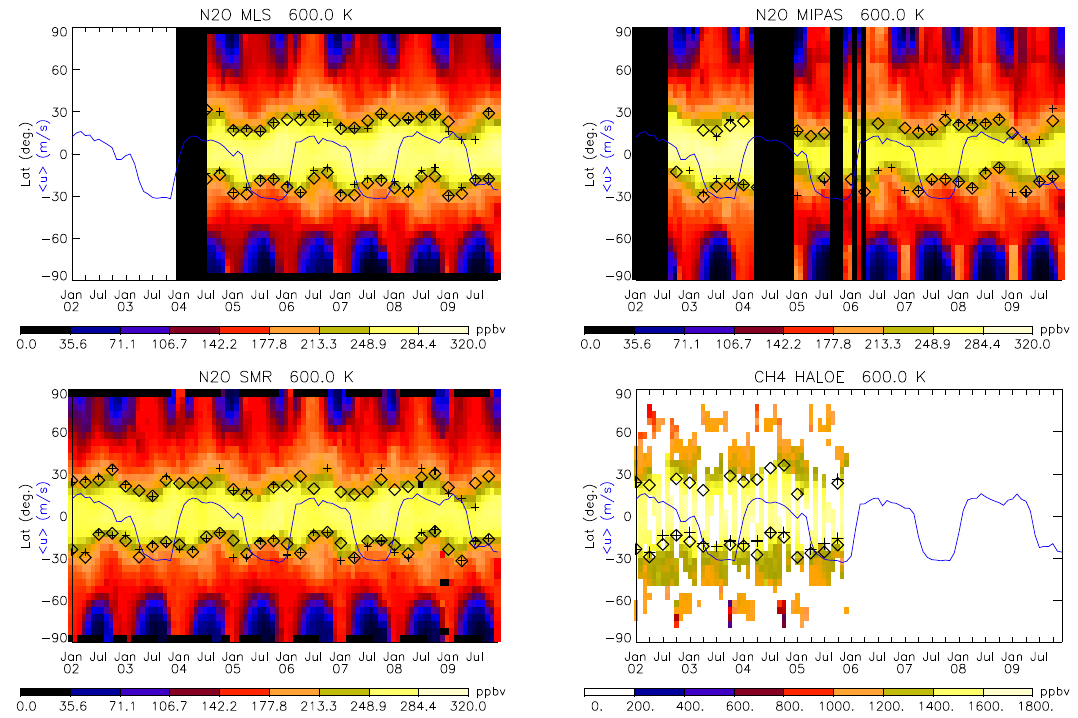
Fig. 1. Latitude-Time section of N 2 O volume mixing ratio (VMR) concentrations (ppb) from MLS (top left), MIPAS (top right), and SMR (bottom left) observations and of CH 4 VMR concentrations (ppb) from HALOE observations (bottom right) at 600K ( ∼ 30hPa); rhombus (cross) symbols overplotted mark the position of the subtropical barrier calculated from the subtropical minimum of the tracer PDF (meridional gradient maximum of the tracer field). The blue line indicates the zonal mean zonal wind at 30hPa measured at Singapore (1 ◦ N, 104 ◦ E)